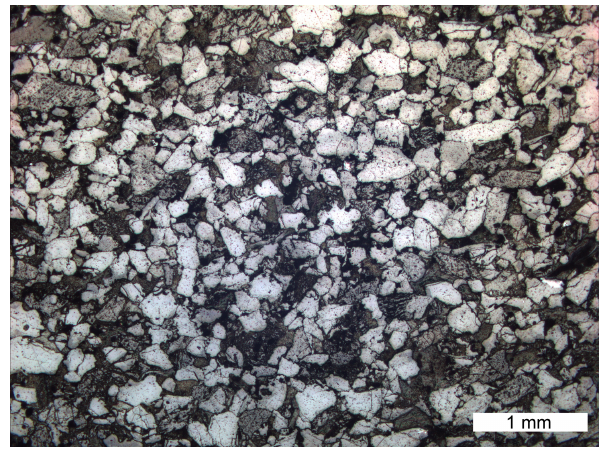
Figure 1. Microscopic image of Darley Dale sandstone, taken in plane polarized light using an optical